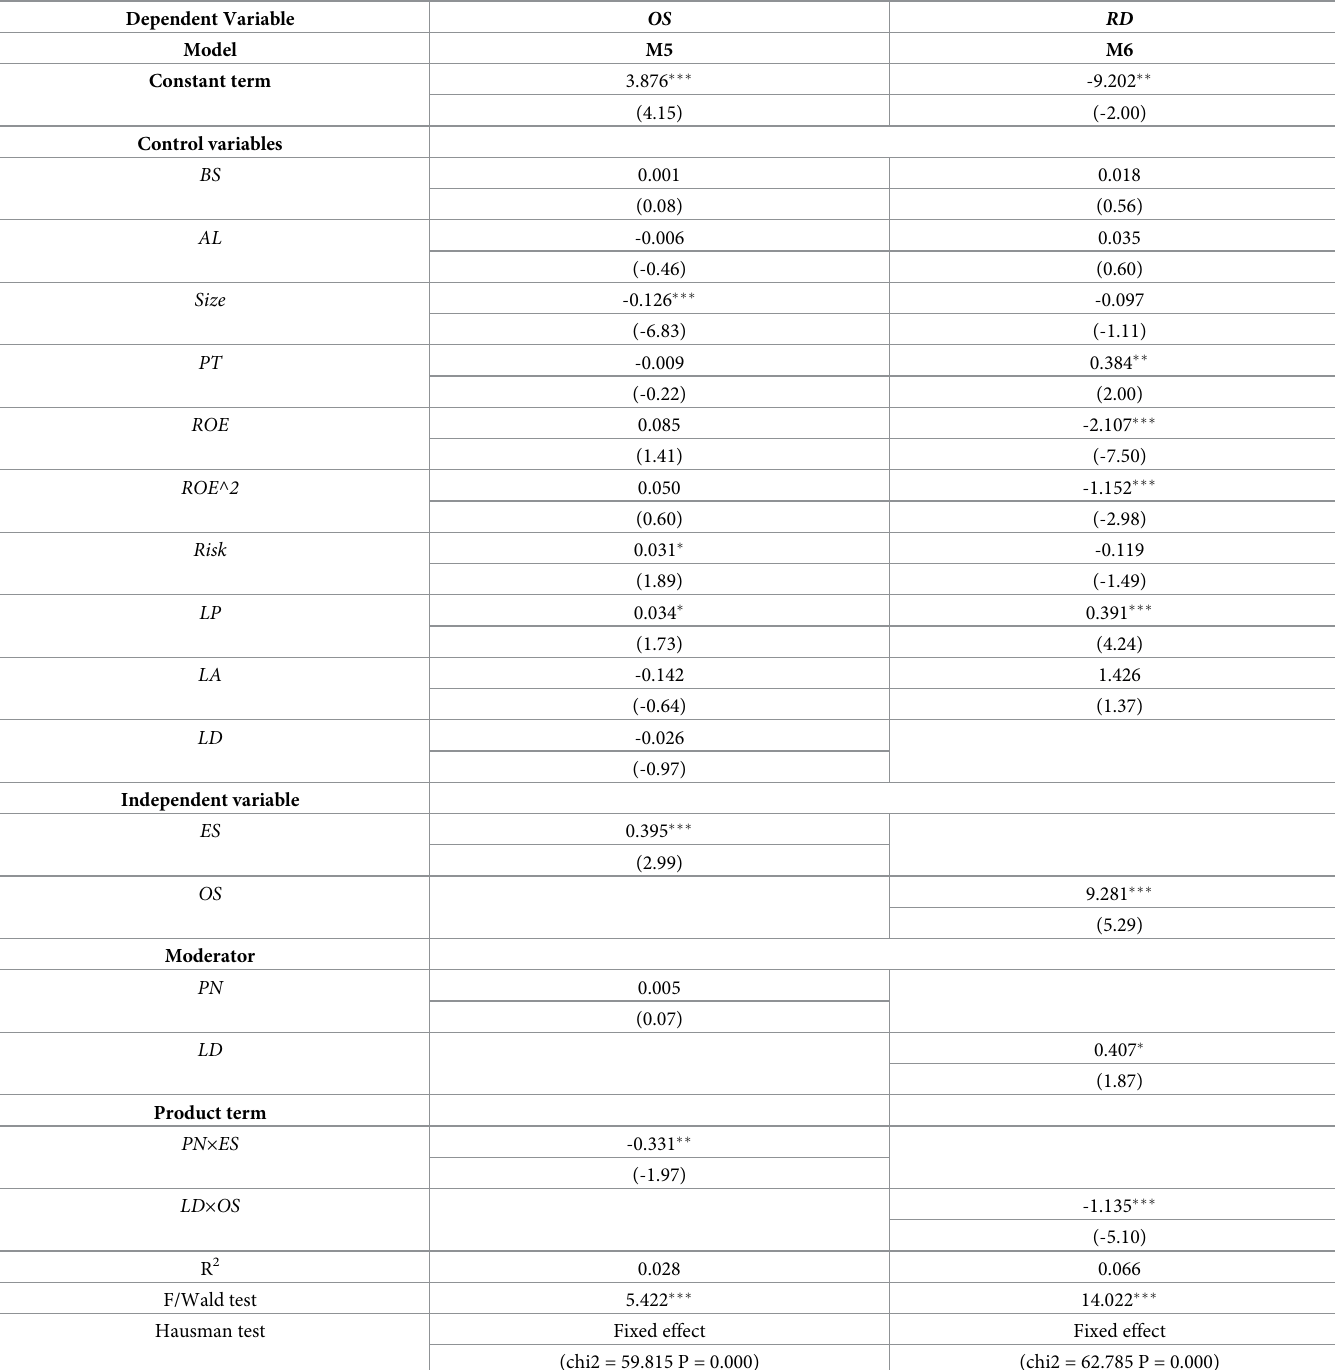
Table 5. Results of regression analysis—moderating